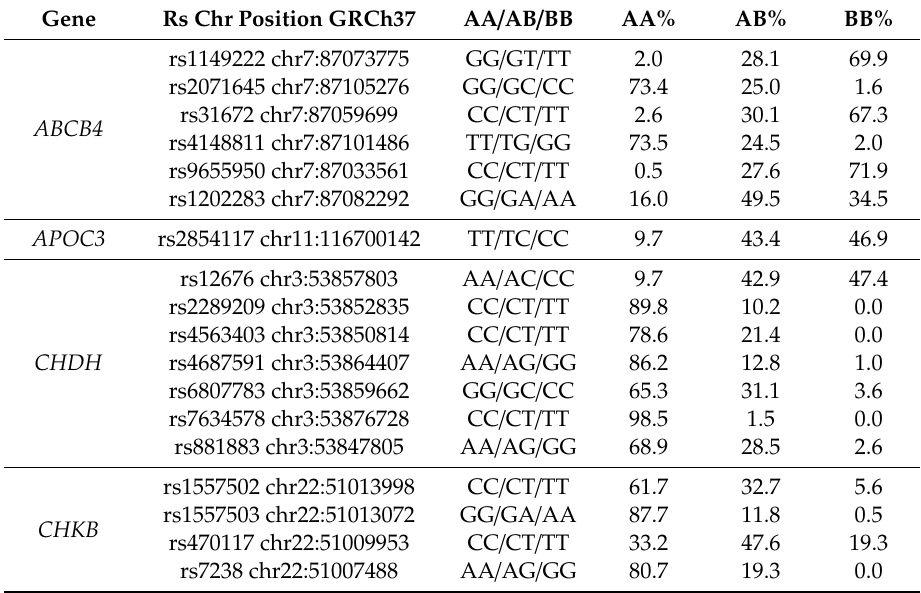
Table A2. The frequencies of 55 single nucleotide polymorphisms studied within 196 subjects.